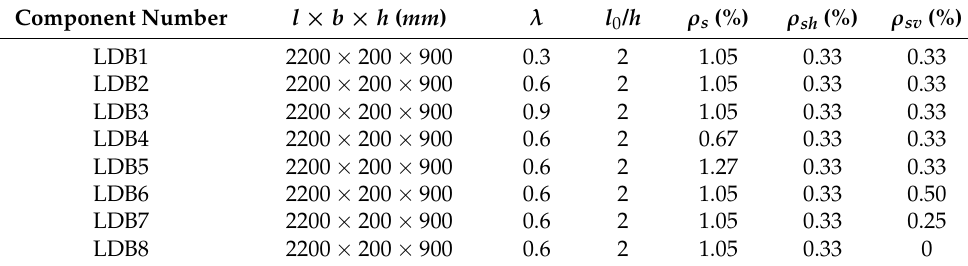
Table 3. Specimens design